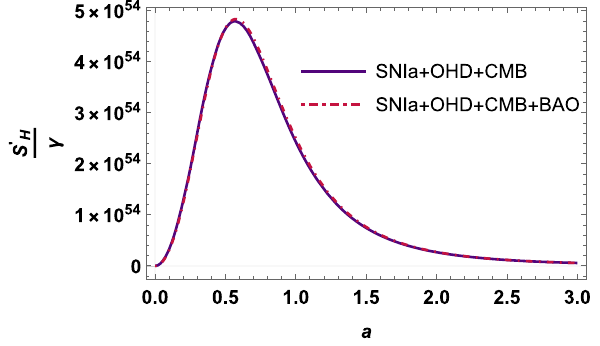
(cid:2) H γ with scale factor for the best estimated Fig. 11 The evolution of S values of the model parameters using the fourth and sixth datasets